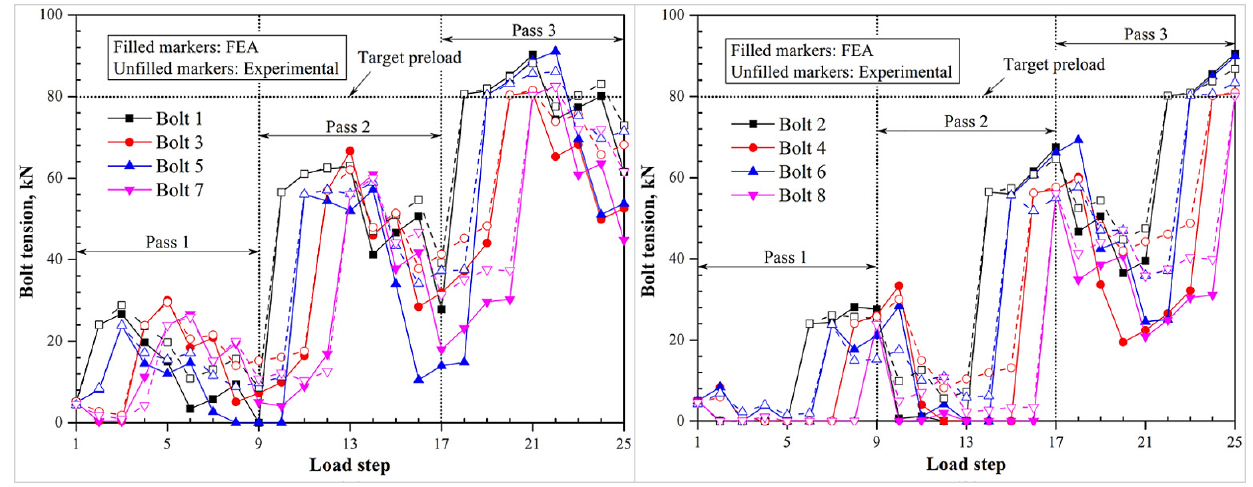
Figure 12. The change curve of bolt preload during the three-step tightening test [64] . Huang [65] analyzed the influence law of the number of tightening steps, tightening step length, and tightening sequence on the fluctuation of the preload by combining the principles of elastic positive and negative interactions, and proposed a two-step load- ing method for the flange bolt structure without rabbet: a first step using the crossover method to tighten to 80% of the target preload, and a second step using the sequential tightening method to tighten to the target preload. Duffey [66], Vincenzo [67], Hu [68], and Li G et al. [69] determined the main factors that affected the bolt preload by establishing a three-dimensional bolt tightening model and optimized the process parameters for ap- plying the bolt preload. Li et al. [70,71] studied the effects of the tightening method, the number of tightening steps, and the tightening speed on the magnitude and stability of the preload based on the TC4 titanium alloy single-bolt connection process test, explored the short-term decay law of the bolt preload, and found that the use of the torque angle method, the use of three-step tightening, and the increase in rotational speed could smooth the fluctuation of the preload and, thus, improve the control of the preload. As shown in Figure 13, Zhao et al. [72,73] investigated the effects of tightening time, lubrication method, and bolt and nut quality on the uniformity of the bolt preload using the torque method for the deflated nut tightening control of the aeroengine’s rotor flange bolt connection structure, and proposed a correction model for the tightening torque–preload relationship including the self-locking torque, finding that repeated tightening would affect the surface. It was found that the surface roughness would be reduced by repeated tightening, while sufficient lubrication could reduce the fluctuation of the